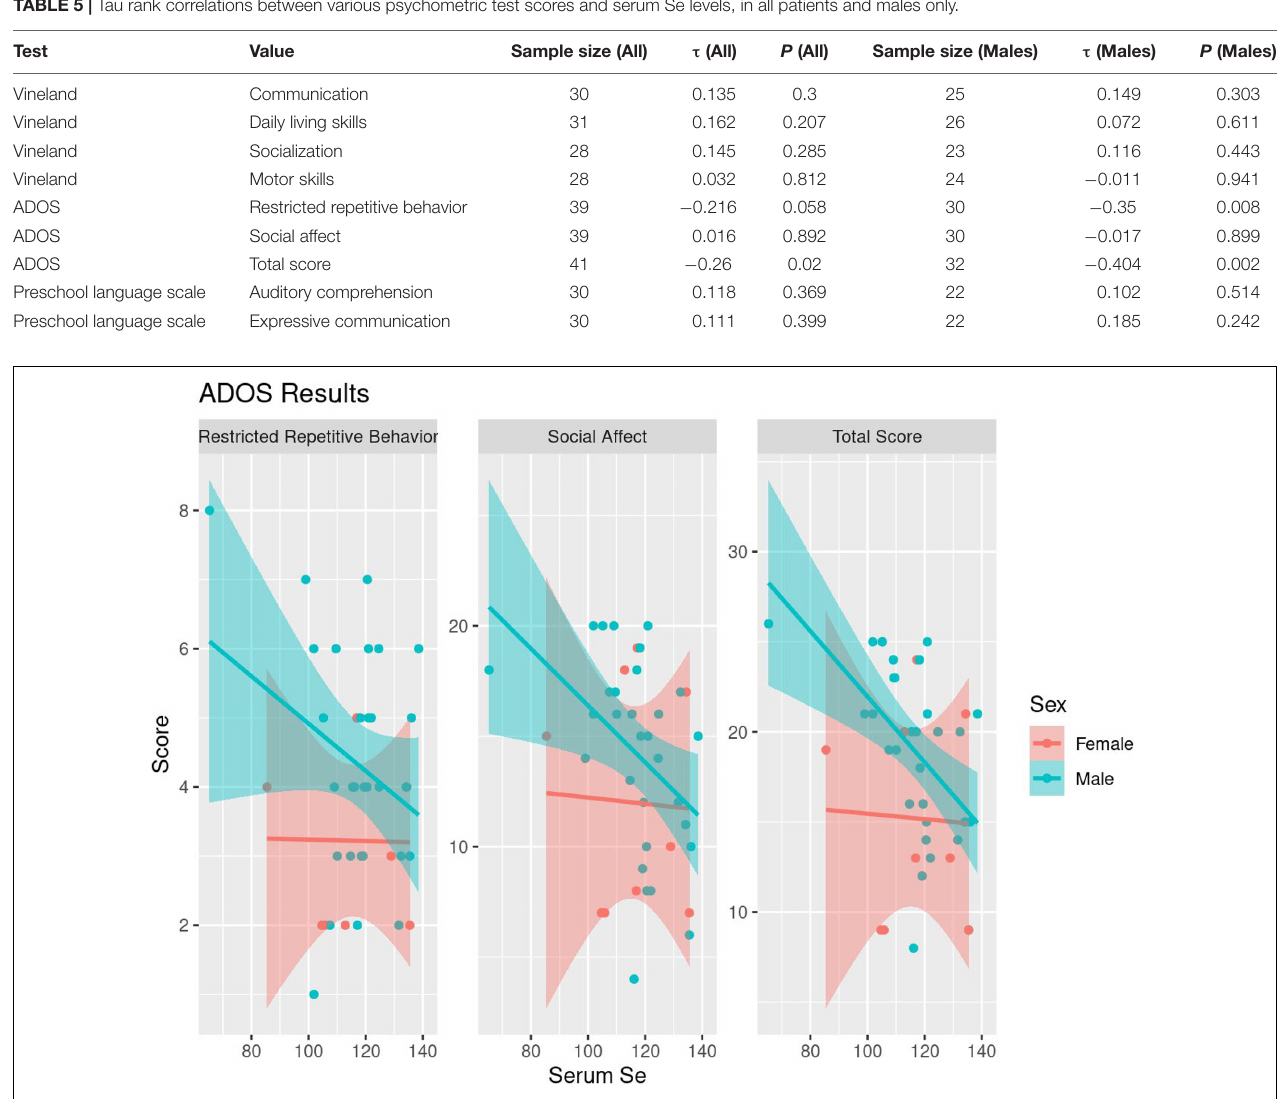
FIGURE 2 | Scatterplots of ADOS Results and serum Se levels along with fitted linear trends, stratified by sex.